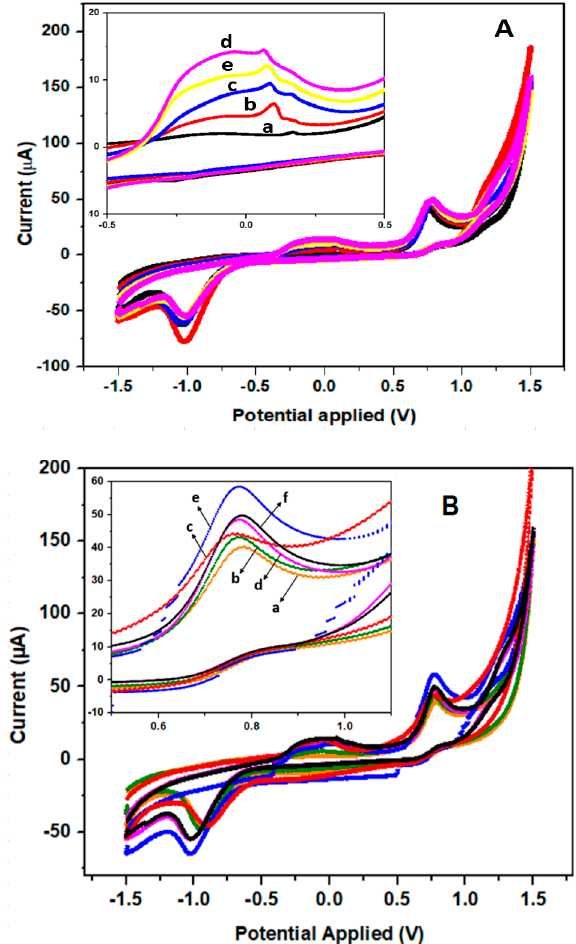
Figure 1. ( A ) Cyclic voltammograms of (a) pure PAni, PAni/MCC nanocomposite with mass ratio of Ani/MCC (b) 0.37/0.63, (c) 0.56/0.44, (d) 0.74/0.26, (e) 0.93/0.07, ( B ) Cyclic voltammograms of PAni/MCC/CTAB nanocomposite prepared from solutions containing different concentrations of CTAB ranging from: (a) 0 cmc (PAni/MCC), (b) 4 cmc, (c) 6 cmc, (d) 8 cmc, (e) 10 cmc (f) 12 cmc. Inset: enlarged anodic peak.